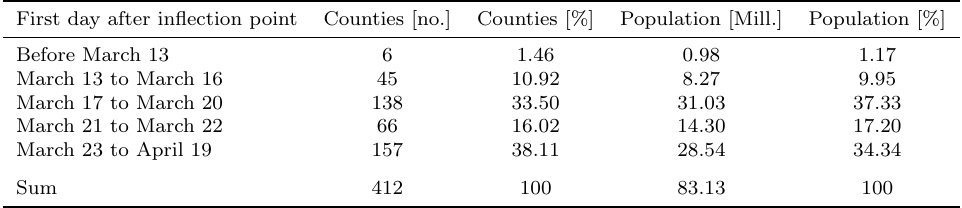
Table 6: German counties by first day after inflection